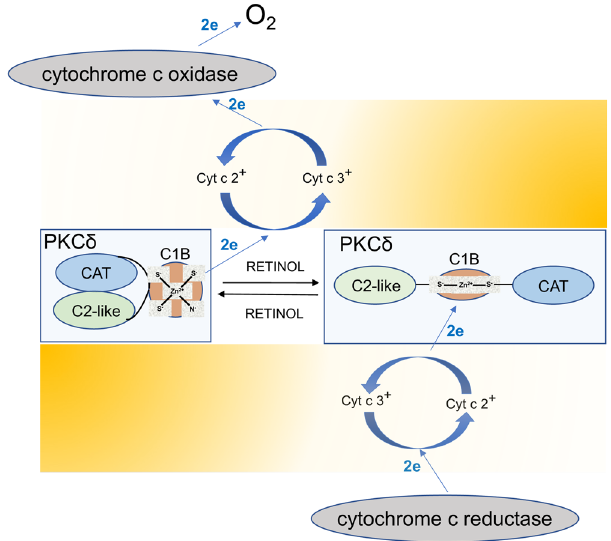
Fig. 2 A binary switch controls the activation/inactivation cycle of PKC δ . negative redox potential (symbolized by a redox gradient in yellow),